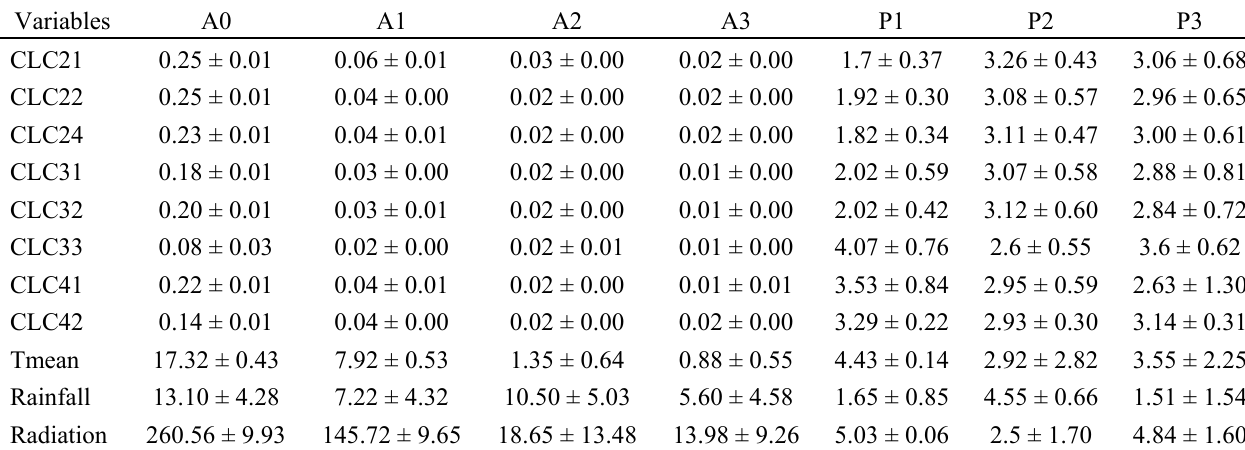
Table 5. Mean (± standard deviation) of the amplitude (A) and phase (P) harmonic parameters of the first three harmonic terms for the different land-covers and selected climatic variables. Phase values are in